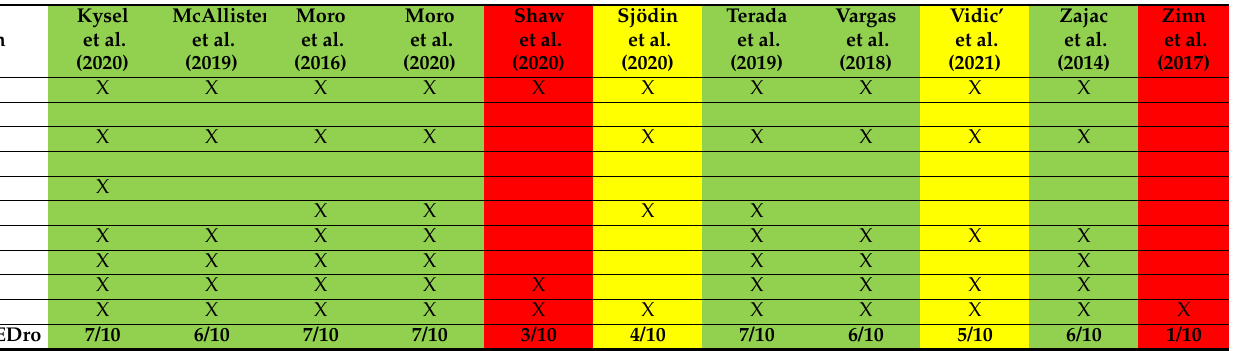
Table 2. Methodological assessment with PEDro scale. Articles 11 to